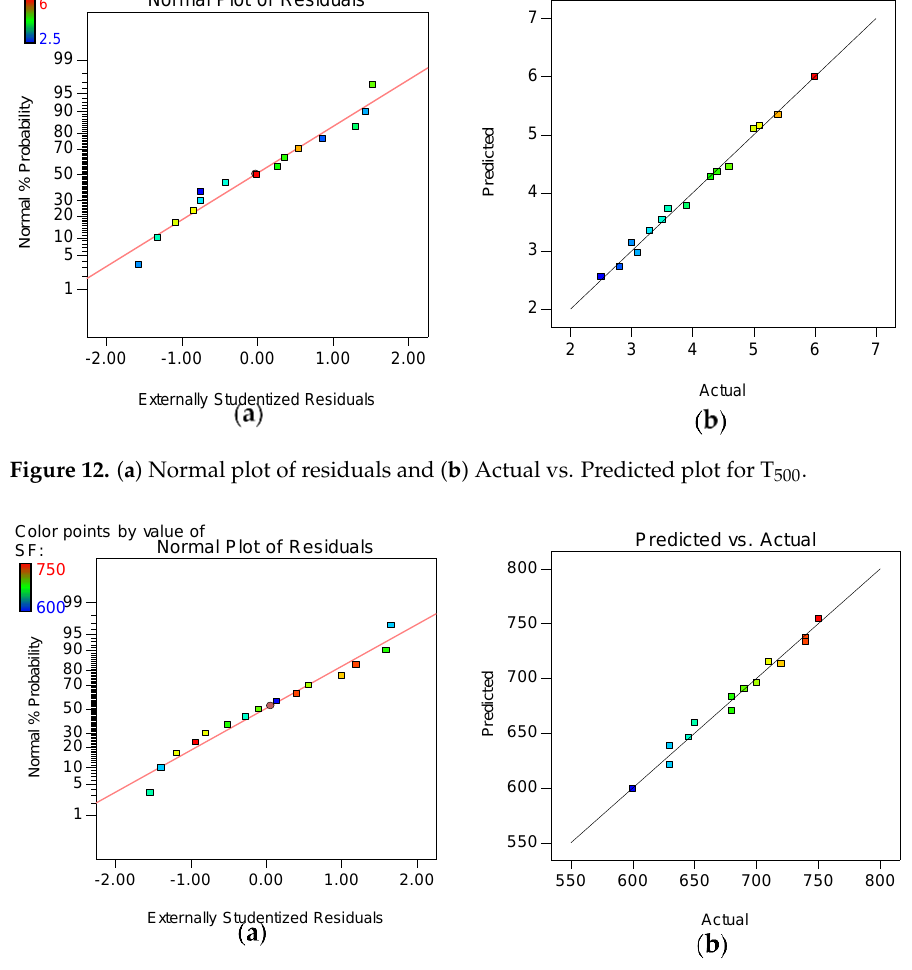
Figure 13. ( a ) Normal plot of residuals and ( b ) Actual vs. Predicted plot for SF.